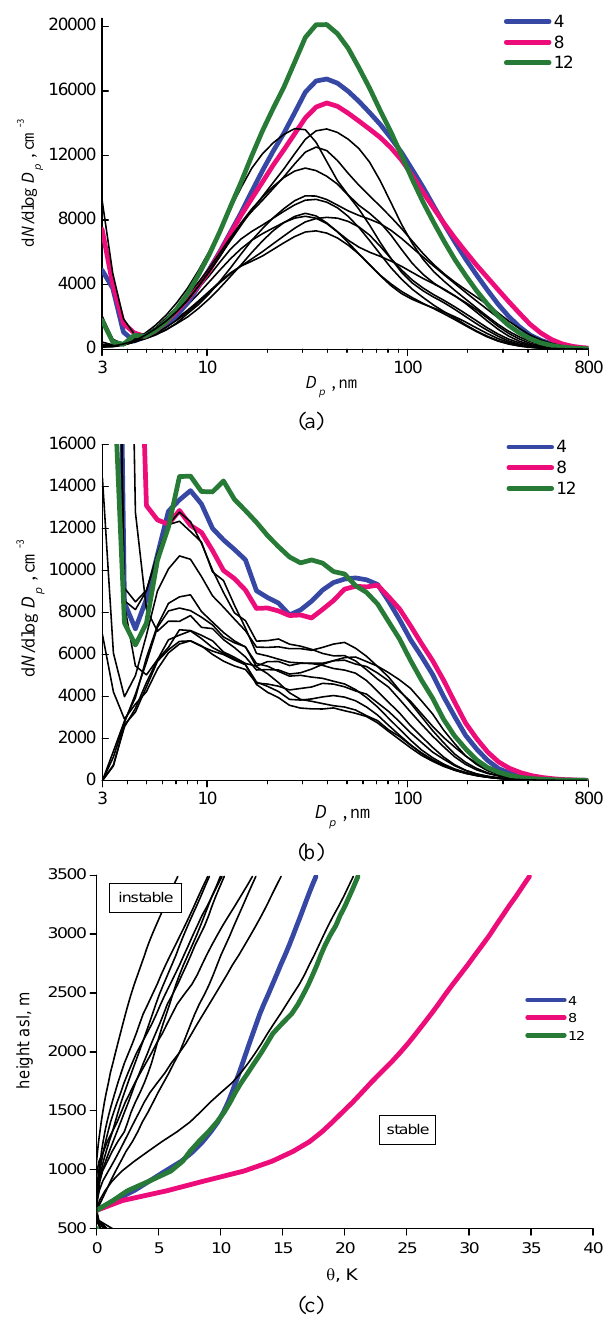
Fig. 14. Mean characteristics of the 13 back trajectory clusters. The selection highlights the three clusters exhibiting the accumu- lation mode particle concentrations (4, 8, 12). All other clusters are only indicated as black lines. For detailed concentrations, see Table 2. (a) Particle number size distributions (12:00–18:00LT). (b) Non-volatile particle number distributions after volatilisation at 300 ◦ C. High concentrations below D p = 6nm result from artificial nucleation inside the thermodenuder. (c) Mean vertical profiles of pseudopotential temperature ( θ ) recorded at 13:00LT. For a direct comparability all profiles were normalised to zero at h =